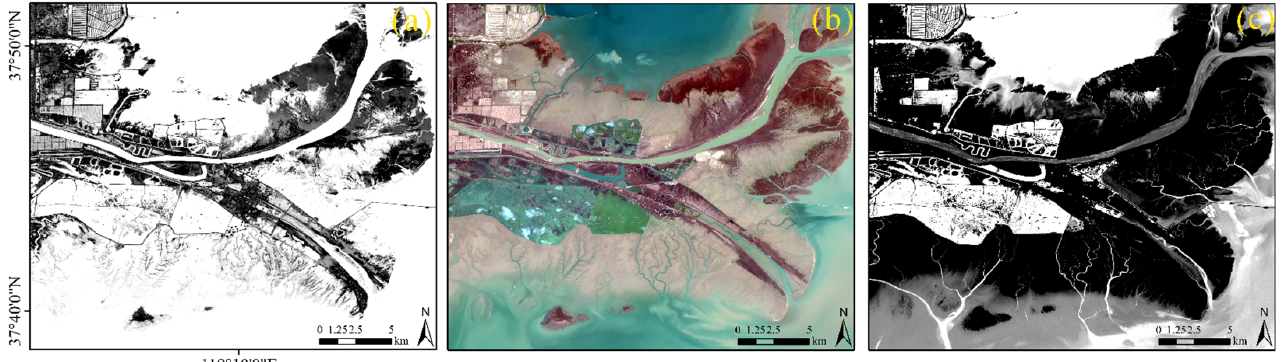
Figure 9. Comparisons of ( a ) mNDWI maximum composite (in grey scale), ( b ) highest tide Sentinel-2 true color image acquired at 02:57 on 10 Feb 2021, and ( c ) NDWI maximum composite (in grey scale) in the Yellow River Delta.